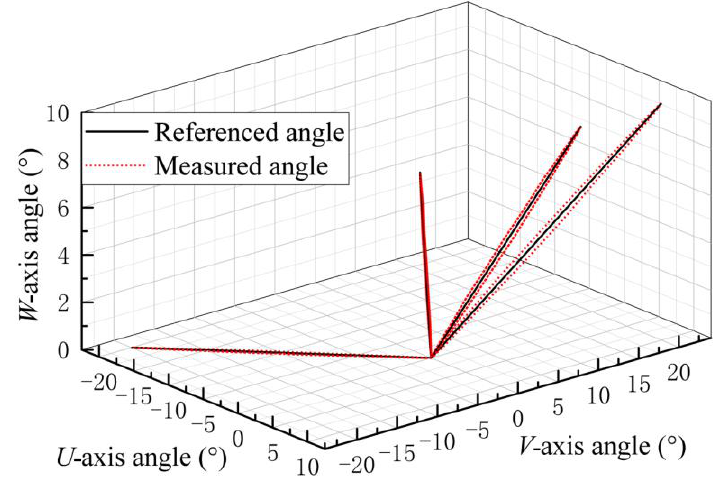
Figure 19. Dynamic-trajectory tracking of a three-axis rotary table.